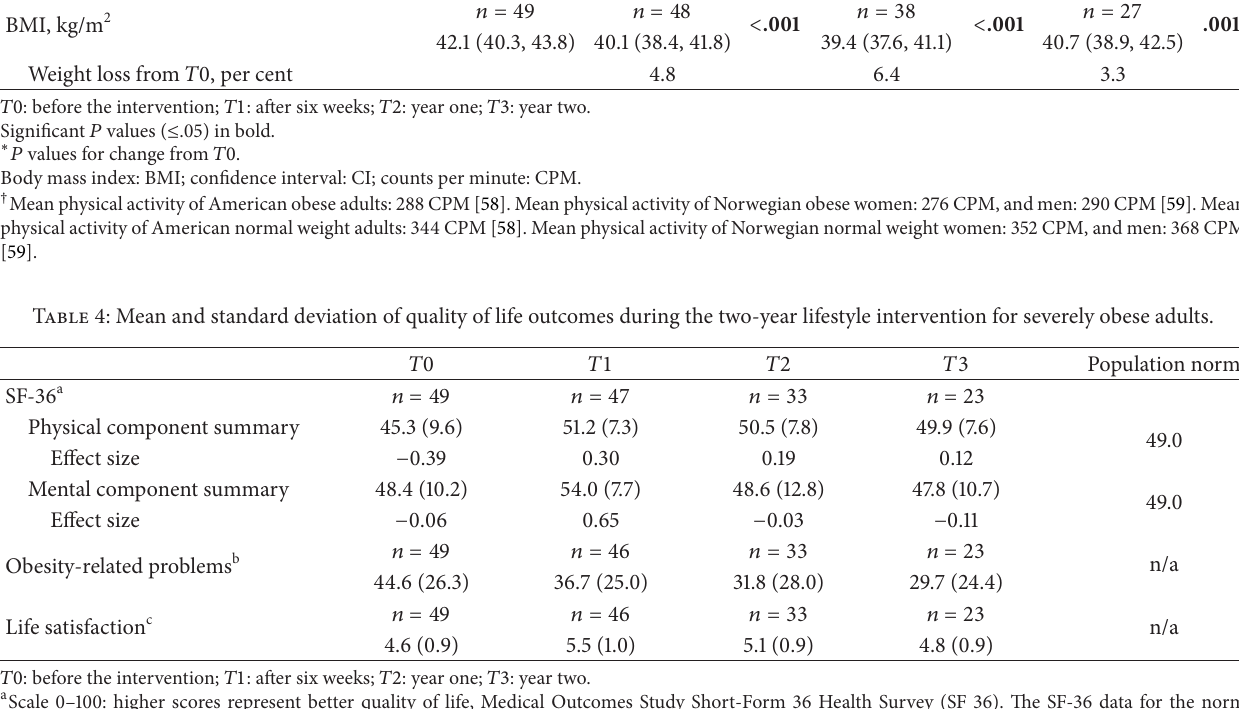
𝑇0 𝑇1 𝑇2 𝑇3 𝑃 ∗ 𝑃 ∗ 𝑃 ∗ Mean (95% CI) Mean (95% CI) Mean (95% CI) Mean (95% CI)